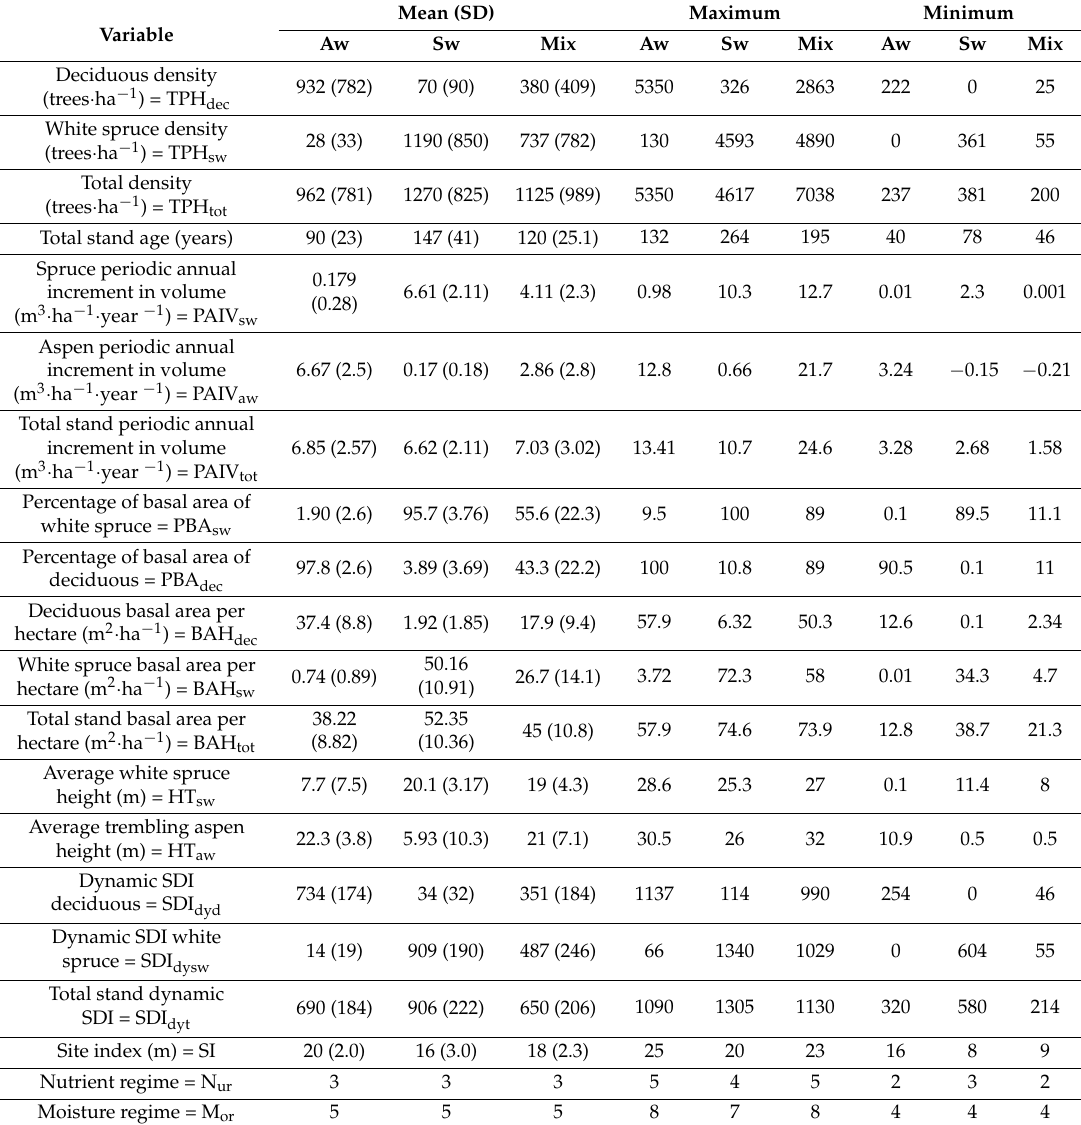
Table 1. Summary of the mensurational characteristics of the selected boreal pure and mixed stands used in this